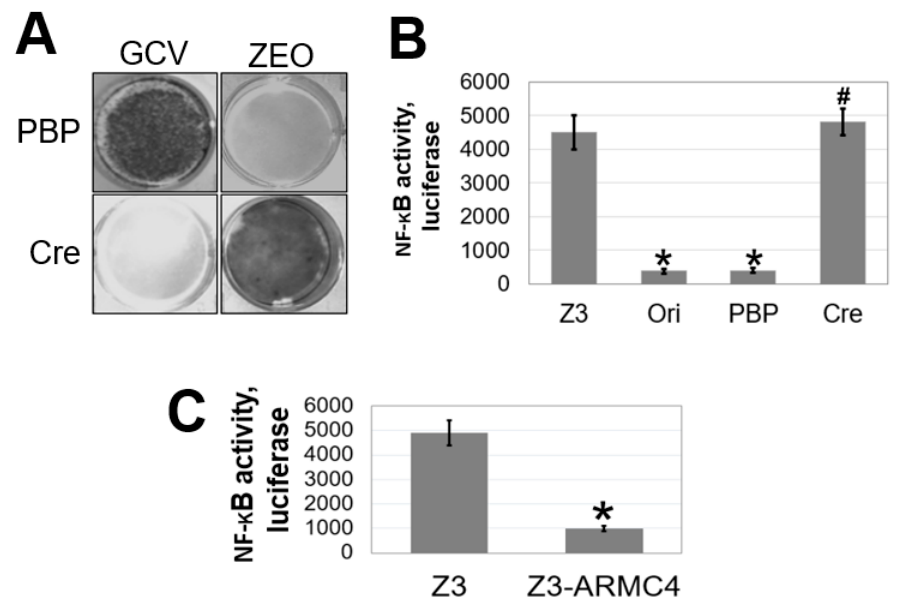
Figure 2. Identification of armadillo-repeat containing protein 4 (ARMC4) as a negative regulator of NF- κ B using a duo-drug selection system. ( A ) Drug sensitivity of an original mutant clone selected from VBIM infected Z3 cells, as depicted from Figure 1 was further infected either with pBabe vector control (PBP) or with the expression of Cre-recombinase (Cre). A low NF- κ B activity mutant with a vector PBP control died in zeocin and survived in GCV, while mutant with Cre expression had reversed phenotype. The cells died in GCV and survived in ZEO. ( B ) NF- κ B luciferase assay, showing Ori mutant cells exhibited decreased NF- κ B activity compared to the Z3 cells. PBP treatment exhibited similar NF- κ B activity to Ori cells, which were reverted by use of Cre-recombinase to a low NF- κ B activity phenotype. * p < 0.01 Ori and PBP vs. Z3 group; # p < 0.01 Cre vs. PBP group. ( C ) NF- κ B luciferase assay, showing Z3 cells stably overexpressing ARMC4 have decreased NF- κ B activity compared to Z3 cells. * p < 0.01 Z3 vs. Z3-ARMC4 group; n = 3.